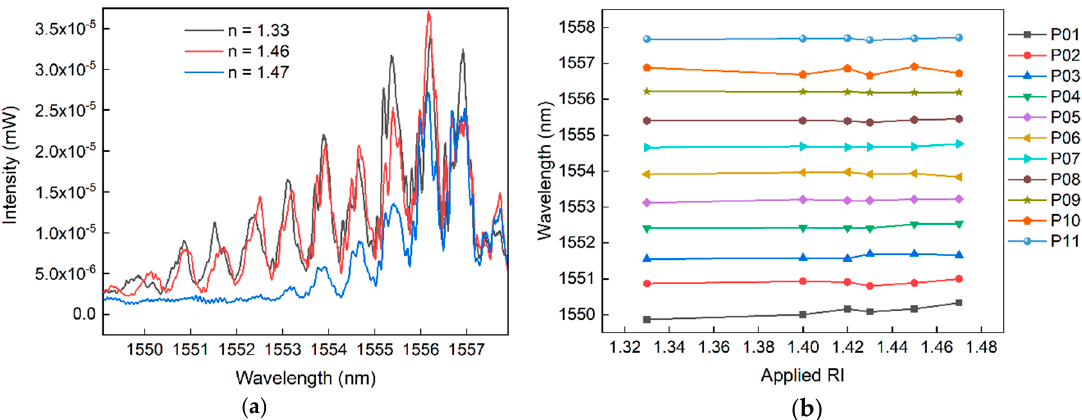
Figure 3. Reflection spectrum of etched GI-MMF with BG for different SRI values ( a ) and the response of the individual Bragg reflection peaks to different applied SRI values ( b ). P01 – P11 indicate the Bragg reflection peaks in the reflection spectrum from left to right, i.e., the Bragg reflection peak of the highest PMG is marked with P01 , whereas the Bragg reflection peak of the lowest PMG is marked with P11 .